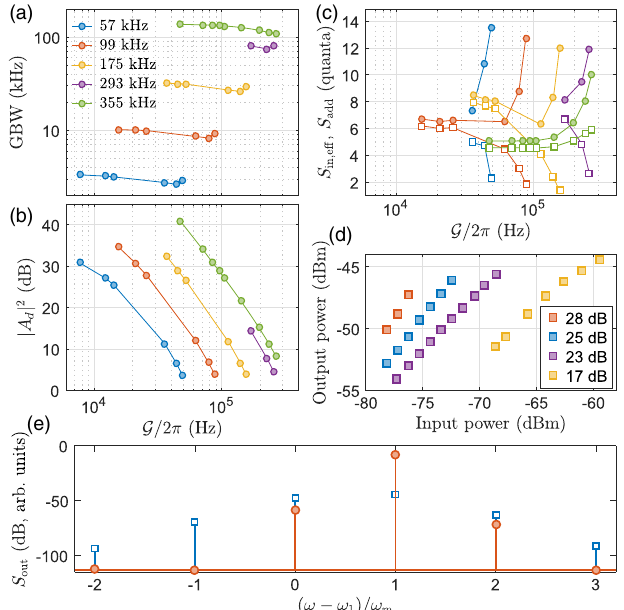
FIG. 3. Amplifier performance and oscillations. (a) Gain- bandwidth product for several values of G − (legends show G − = 2 π ) as a function of G . (b) Peak direct gain and (c) effective input-referred noise (closed circles) and added amplifier noise S (open squares) on resonance, for the same parameters as (a). add (d) Performance of direct amplification at large input powers, measured for G − ≈ 2 π × 350 kHz and several values of G (colors). Legend shows the nominal gain for each setting. (e) Harmonic spectra of oscillations in the instability regime without (open squares) and with (closed circles) the red-detuned pump at ω enabled. For the latter case, each harmonic P − component is measured separately and the horizontal line shows the measurement noise